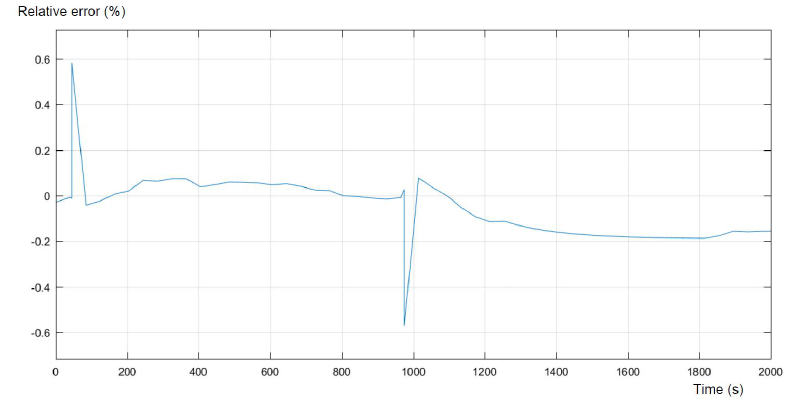
Figure 9. Relative error of the model.